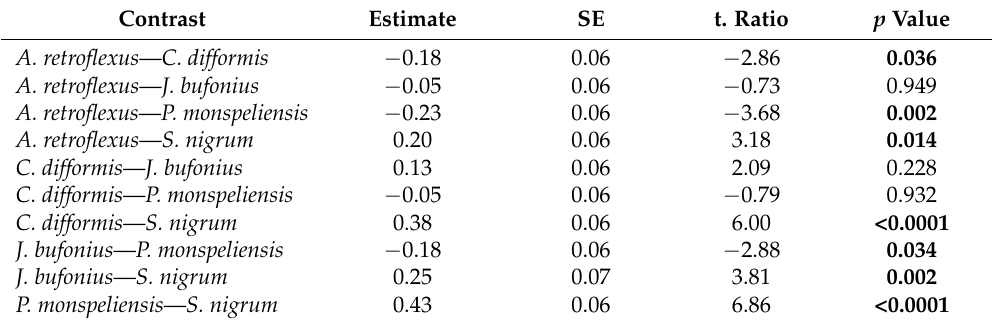
Tukey HSD post-hoc test showing pairwise differences between plant species ( Solanum nigrum, Amaranthus retroflexus, Polypogon monspeliensis, Cyperus difformis and Juncus bufonius ) in the proportion of seeds recovered in gull faeces. Significant p -values are highlighted in